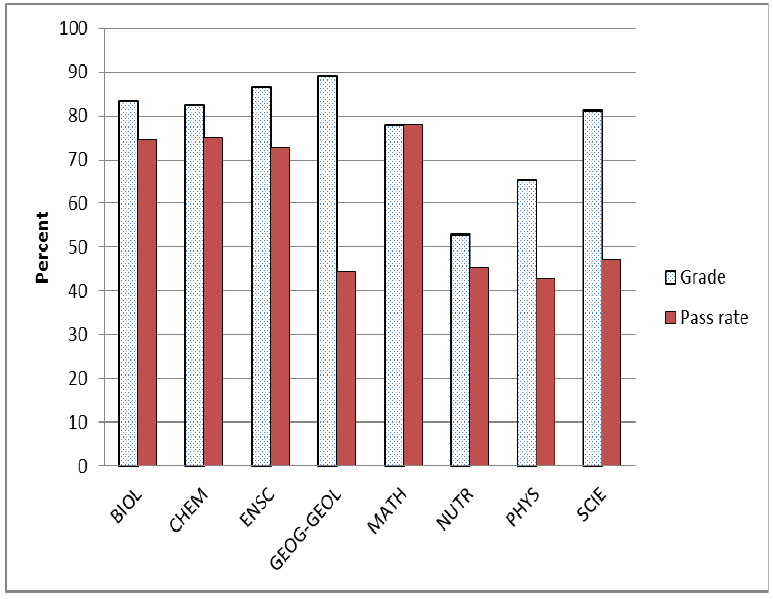
Figure 1 . Average grades and pass rates by discipline. There is no statistical difference in average grades between disciplines.